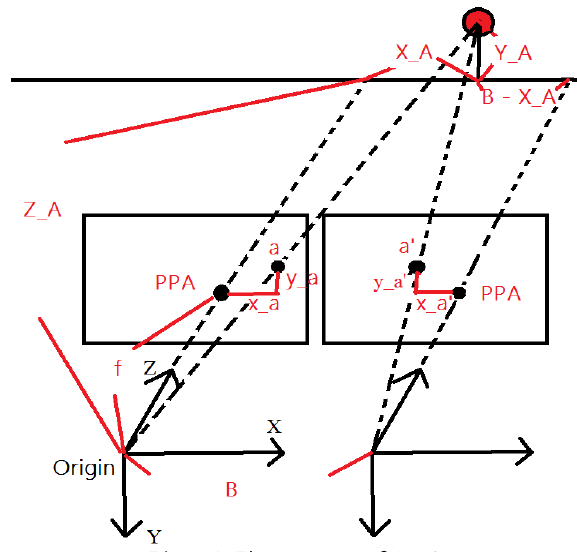
Figure 2. The geometry of